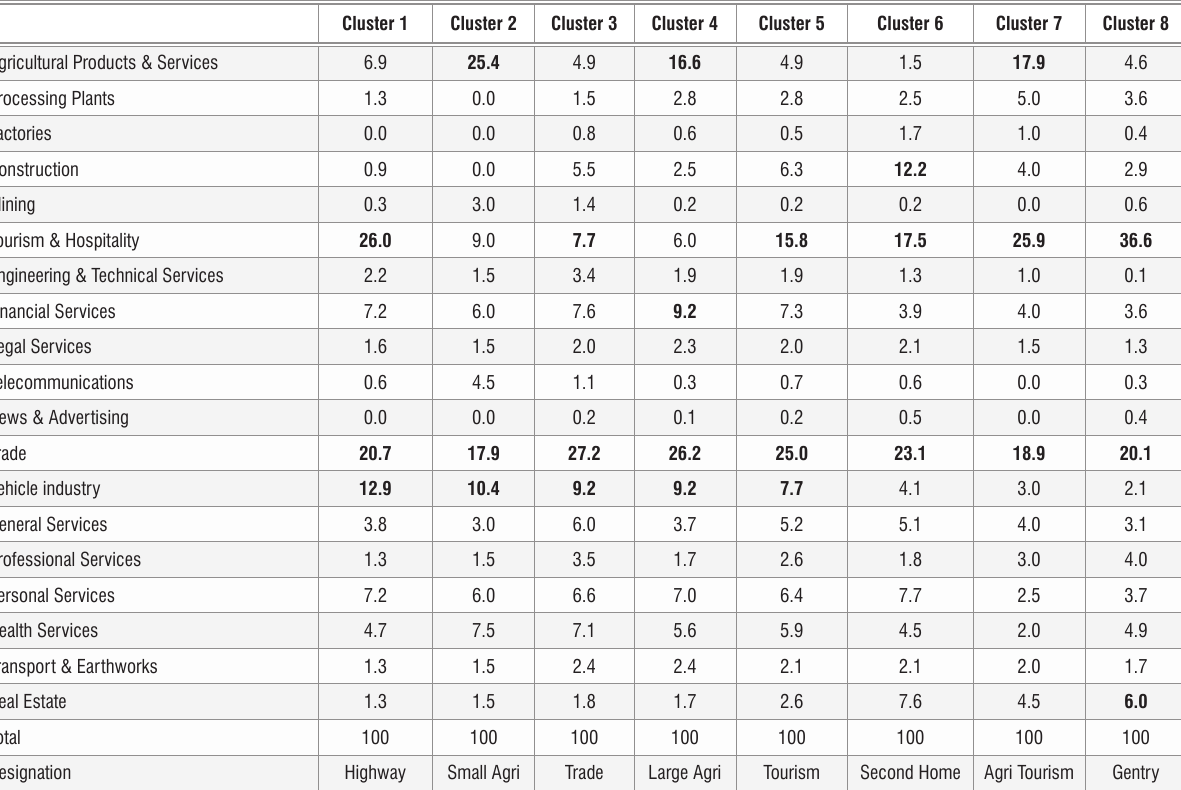
Table 5: The enterprise architecture (percentage composition) of Clusters 1 to 8. The top three sectors for each cluster (four in the case of Cluster 4) are shown in bold.